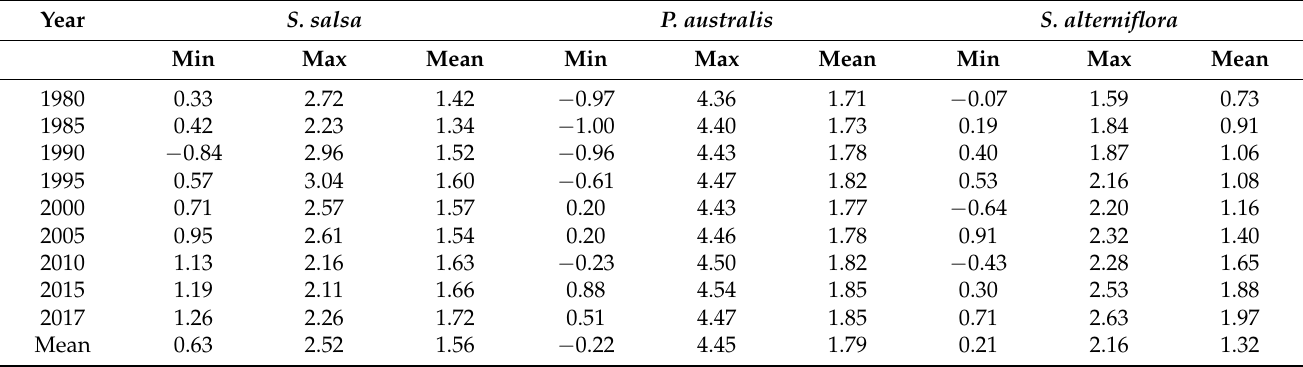
Table 3. Topographic elevation distribution of vegetation (unit: